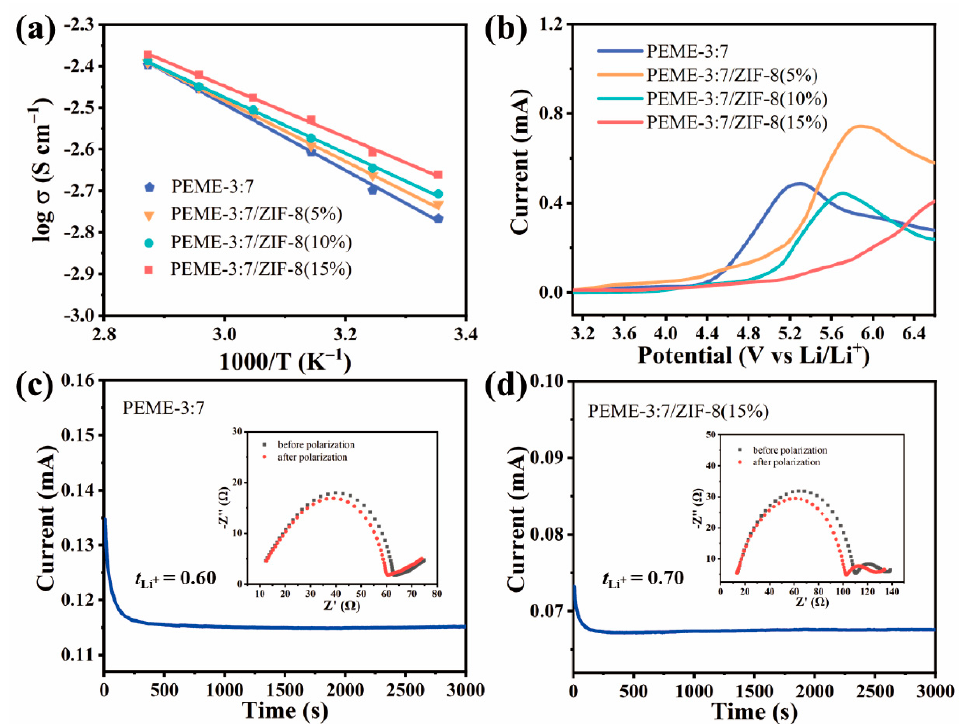
Figure 5. ( a ) Temperature dependence of ion conductivities of PEME-3:7 and PEME-3:7/ZIF-8 membranes. The solid lines are the Arrhenius fitting curves. ( b ) Linear scanning voltammograms of Li||PEME-3:7||SS and Li||PEME-3:7/ZIF-8||SS cells. The chronoamperometric profiles of ( c ) Li||PEME-3:7||Li and ( d ) Li||PEME-3:7/ZIF-8(15%)||Li cells with an applied potential difference of 10 mV (insets: the AC-impedance spectra of the cells before and after the polarization).